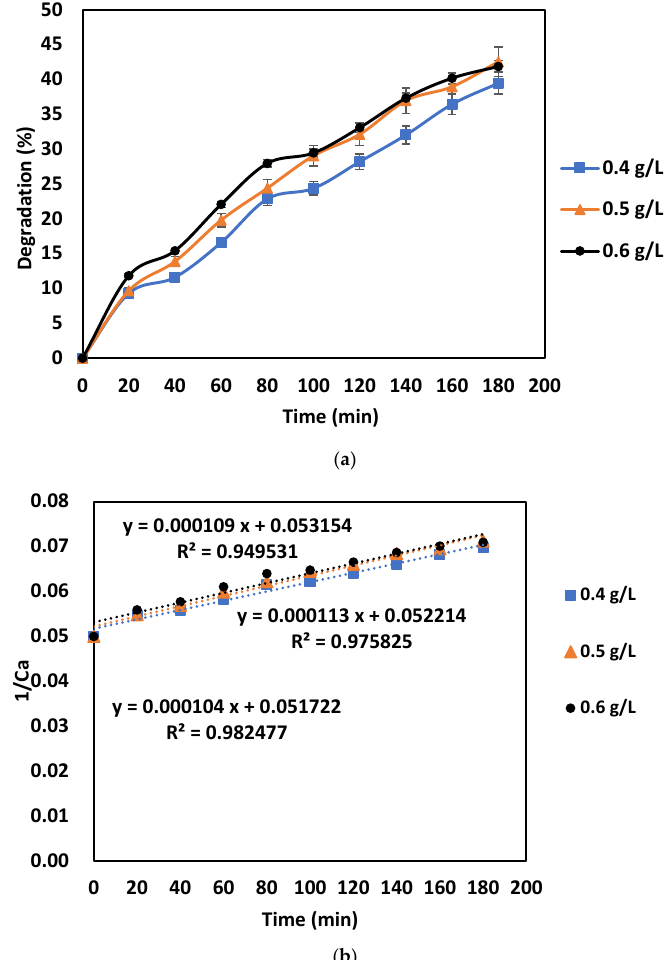
Figure 5. Effect of catalyst dosage on the degradation of Chrysoidine R dye: ( a ) extent of degrada- tion and ( b ) kinetic fitting.